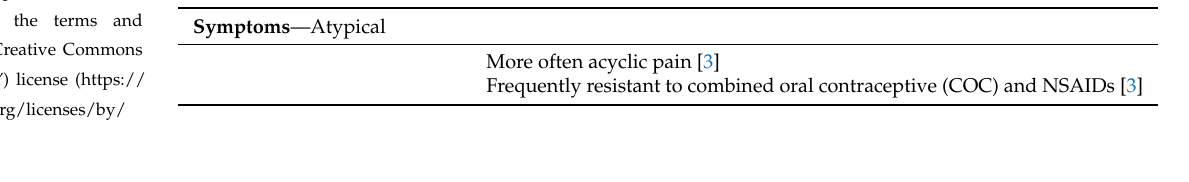
Table 1. Characteristics of adolescent